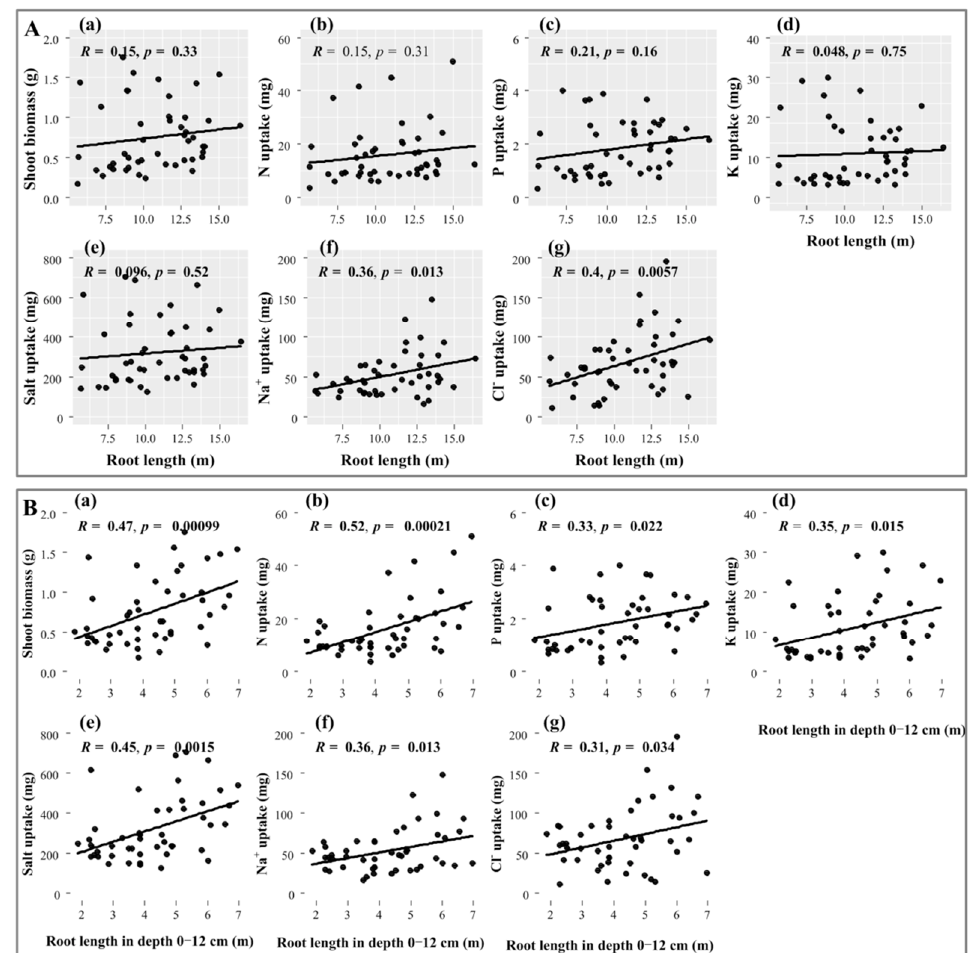
Figure 4. Relationships of total root length ( A ) and root length in depth 0–12 cm ( B ) with shoot biomass, nutrient, and ion uptakes of Suaeda salsa . A , B ( a ), shoot biomass; A , B ( b ), N uptake; A , B ( c ), K uptake; A , B ( d ), P uptake; A , B ( e ), salt uptake; A,B ( f ), Na + uptake; A , B ( g ), Cl (cid:2879) uptake.